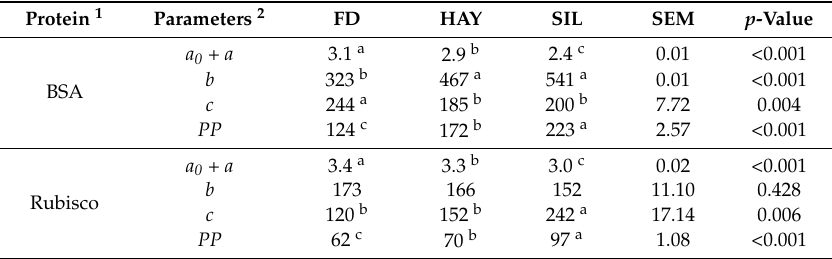
a,b,c Means within a row followed by different letters differ ( p < 0.05). 1 BSA = bovine serum albumin; Rubisco = ribulose 1, 5-disphosphate carboxylase. 2 Parameters were obtained by fitting the amount of precipitated protein (mg) and amount of CT ( µ g) incubated with the equation: y = a 0 + a /(1 + exp( − ( x − b )/ c )), where y = mg of protein (BSA or Rubisco) precipitated, x = µ g of CT incubated, a 0 + a = estimated maximal amount (mg) of protein (BSA or Rubisco) precipitated, b = sigmoidal centre ( µ g of CT at the 50% of maximal protein precipitation), and c = sigmoidal width. PP : protein-precipitating capacity, expressed as µ g CT required to precipitate 1 mg of protein. SEM, standard error of the